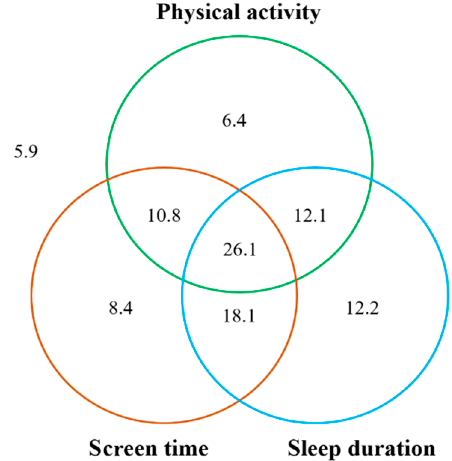
Figure 2. The numbers within each circle are added to the proportion of children meeting each individual guideline (i.e., 55.4% for physical activity, 63.4% for screen time and 68.4% for sleep duration). The total non-overlap area of each circle represents the proportion of children meeting one of the three guidelines (i.e., 6.4% + 8.4% + 12.2% = 27.0%). The total overlap areas of two circles represents the proportion of children meeting two guidelines of the three guidelines (i.e., 10.8% + 18.1% + 12.1% = 41.0%). The overlap area of three circles represents the proportion of children meeting all three guidelines (i.e., 26.1%). The outside area of the circle represents the proportion of children not meeting any of the guidelines (i.e.,